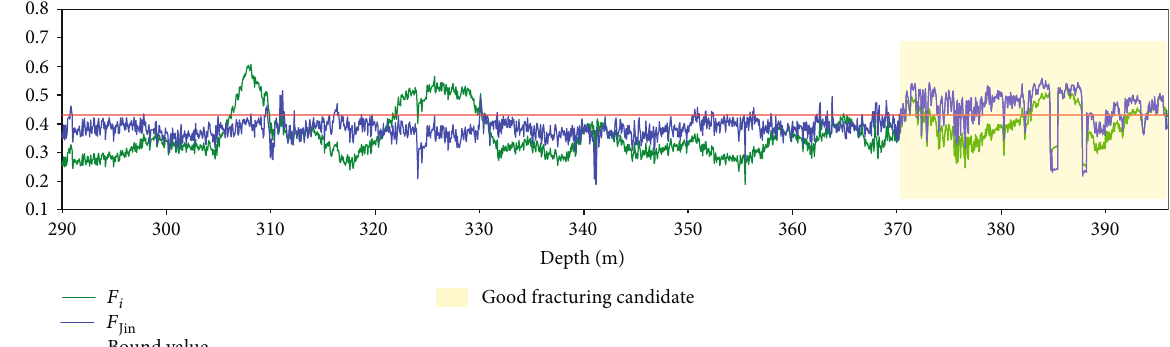
fi ned in this paper and F